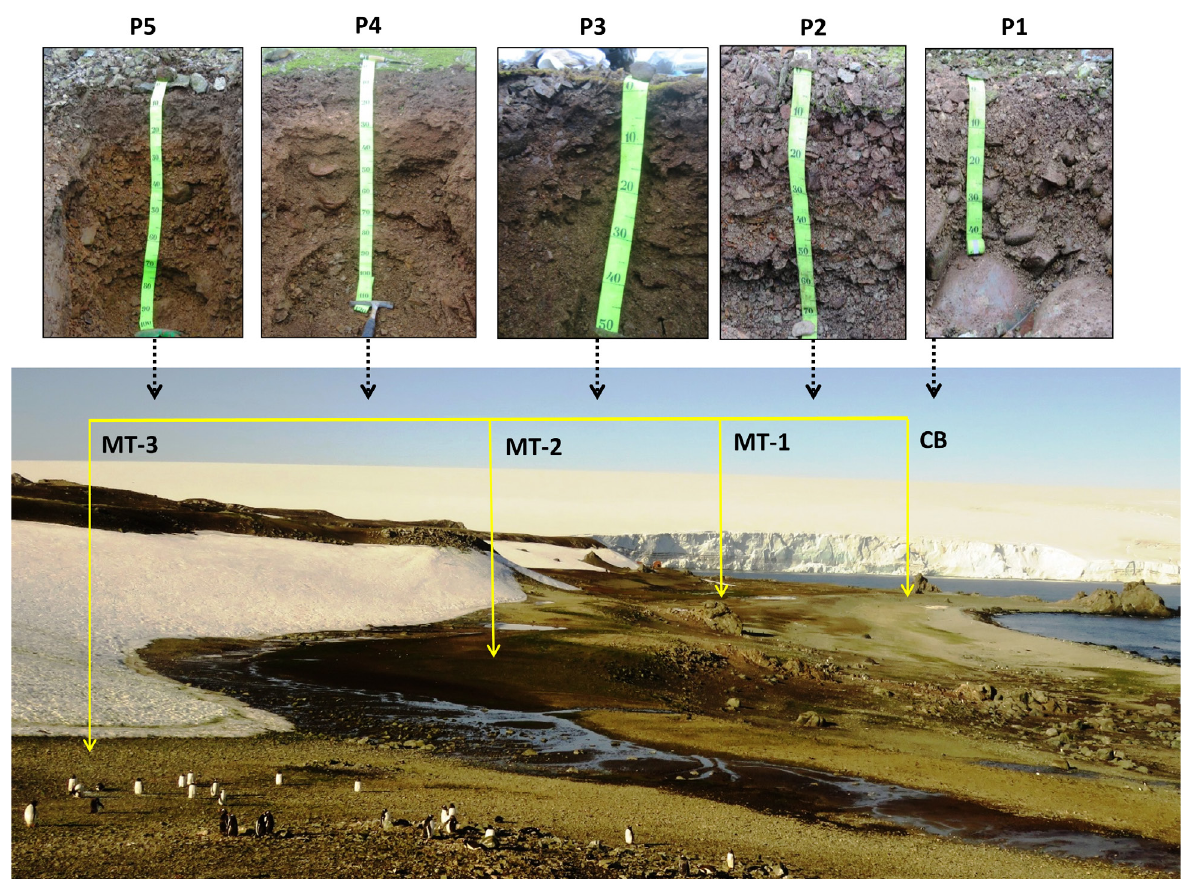
Figure 2. Coastal domain of HP and its respective levels of marine terraces and studied profiles. P1- current beach (CB); P2- marine terrace 1 (MT-1); P3- marine terrace 2 (MT-2); P4 and P5- marine terrace 3